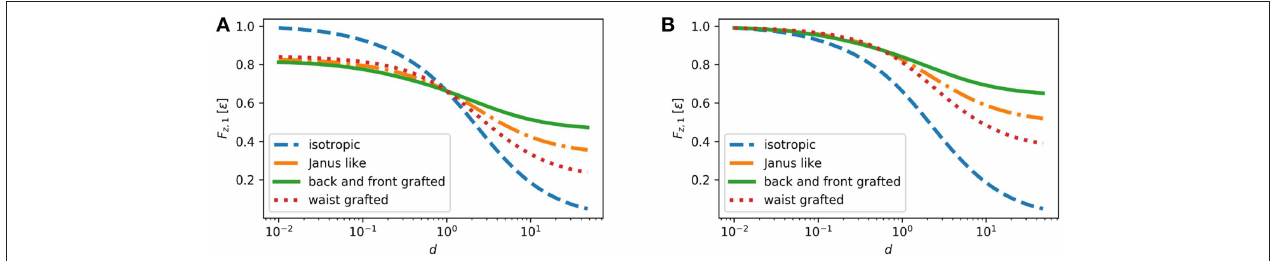
FIGURE 9 | The first order correction to the drag force F z ,1 = ( F z − 1) / ( − 6 π ) (see Equation 25) for three cases of the grafting geometry as defined by Equations (32–34) compared to the case of isotropic (bare) particle Equation (31). Polymer concentration profiles corresponding to the drag force for the Janus and back-front quadrupolar grafting in (A) are shown, respectively, in panels (A,B) in Figure 8